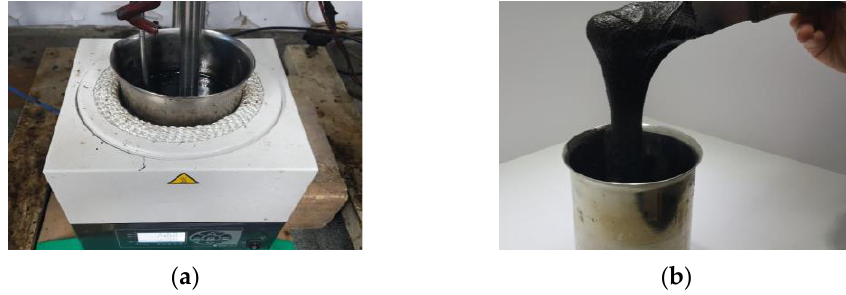
Figure 4. W-SPRG mixture and extraction. ( a ) W-SPRG mixture. ( b ) W-SPRG extraction. Table 2. Other components and range of W-SPRG.